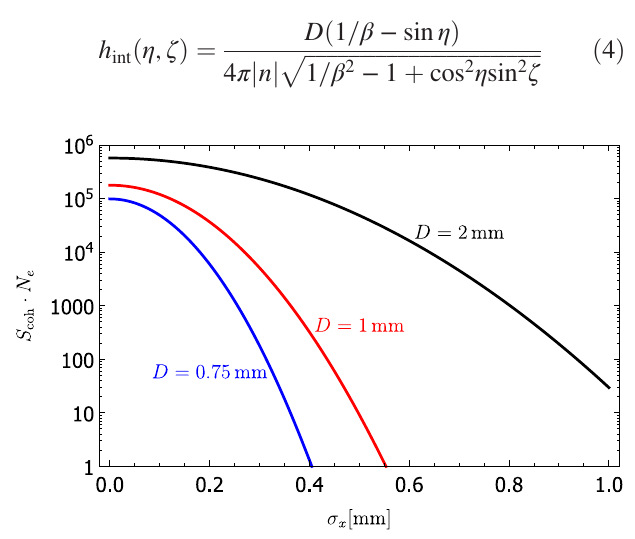
for different coh